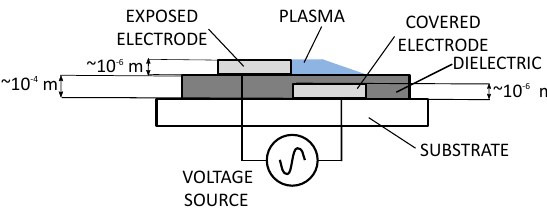
Figure 3. Schematic of a plasma actuator with indicative sizes according to